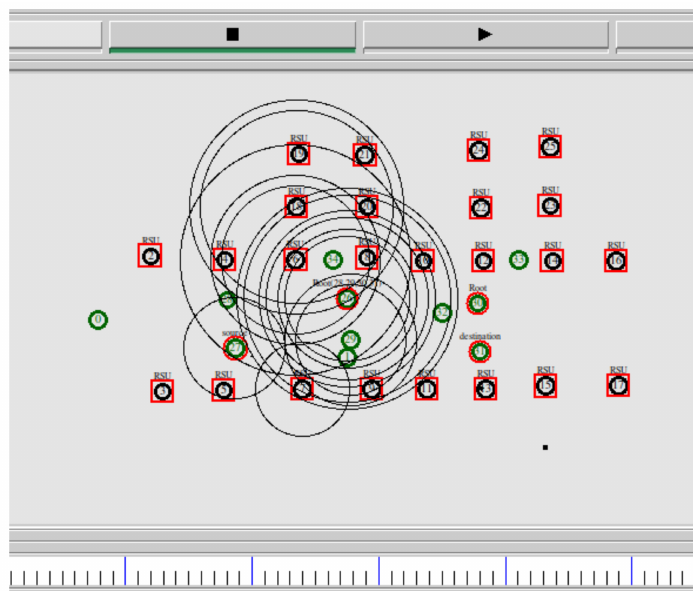
Figure 4. Root node sends a Route Reply